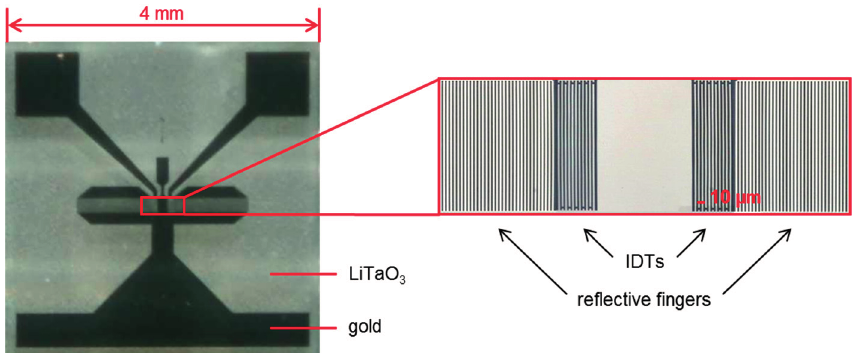
Figure 2. SAW resonator type SR062 consisting of LiTaO 3 substrate with gold transducers.